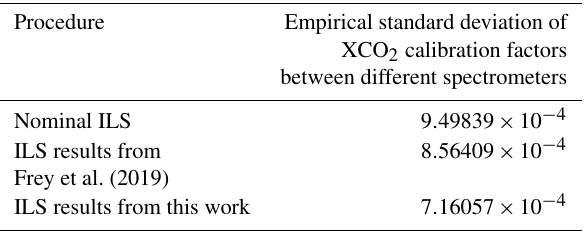
Table 5. Impact of ILS parameters on XCO 2 calibration factors (this statistic encompasses the subset of spectrometers that has been treated in the study by Frey et al.,